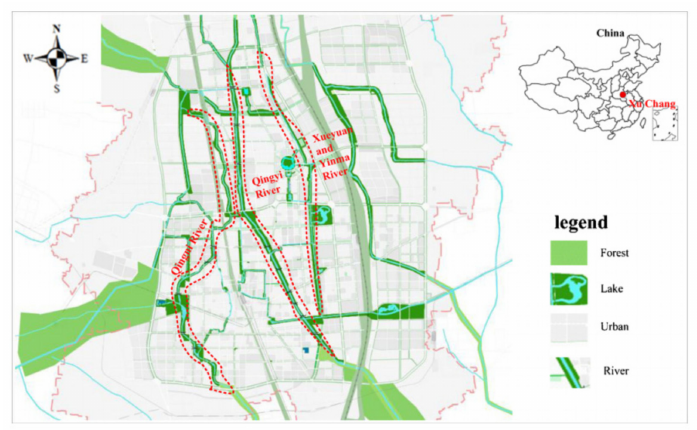
Figure 3. The research region of the UWETP-PPP in Xuchang